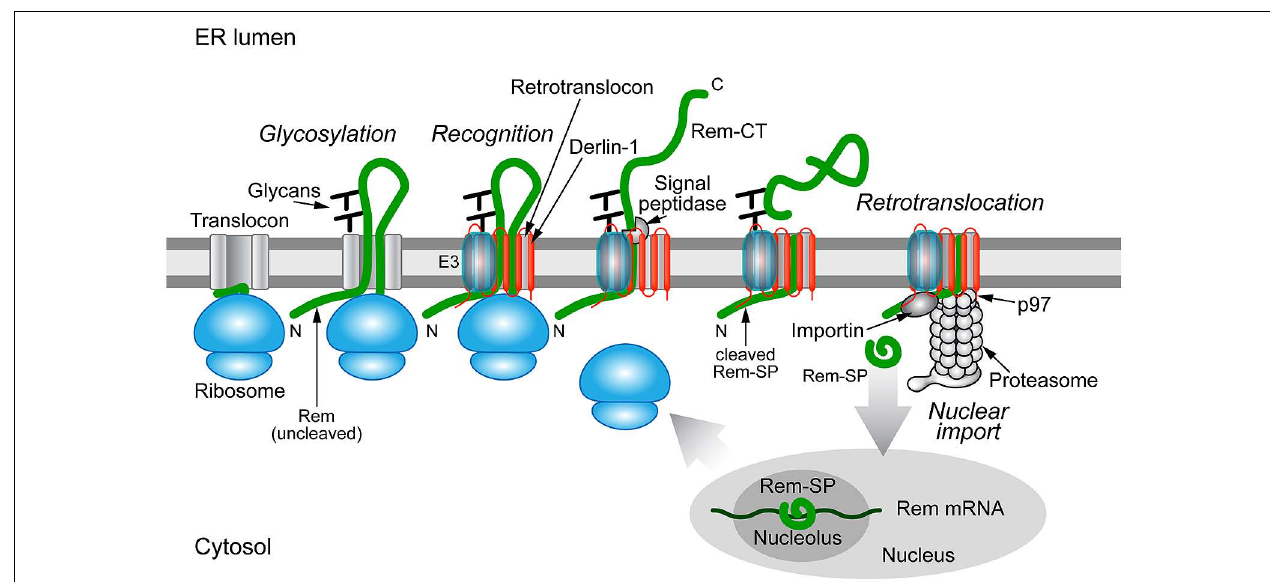
FIGURE 4 |Trafficking of the MMTV Rem protein by subversion of ERAD. Rem is a precursor protein that has an N-terminal signal peptide (Rem-SP) that directs translation to the ER membrane.The Rem-CT enters the ER lumen, where it is modified by N-glycosylation on two different sites. Rem recognition for retrotranslocation is not understood, but appears to involve Derlin-1 and, potentially, an E3 ligase, although ubiquitinated Rem has not